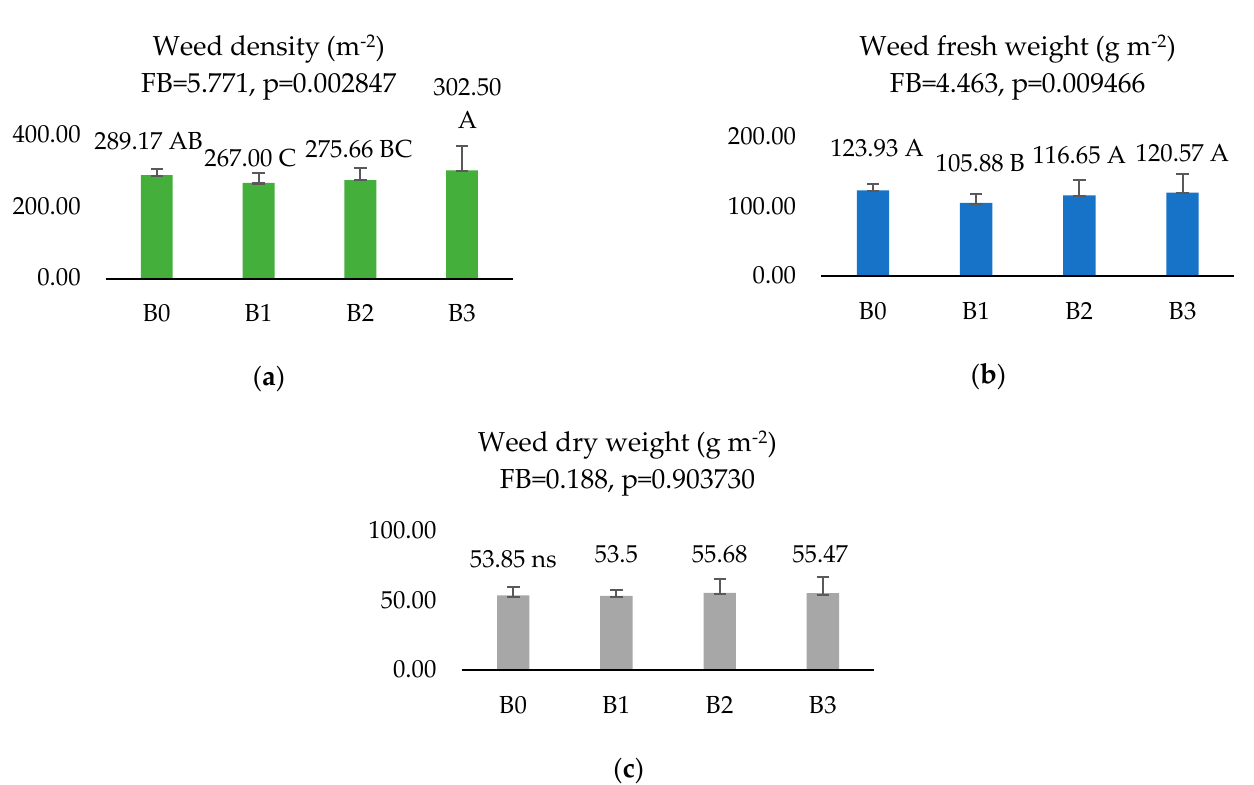
Figure 5. Influence of different biochar treatments (B0-0 t ha − 1 , B1-5 t ha − 1 , B2-10 t ha − 1 , B3-15 t ha − 1 ) on weed density (a), weed fresh weight (b) and weed dry weight (c). FB—F-test for biochar treatments, p–p value. Columns marked with different capital letters are statistically different using the protected least significant difference (LSD) test at P < 0.05.